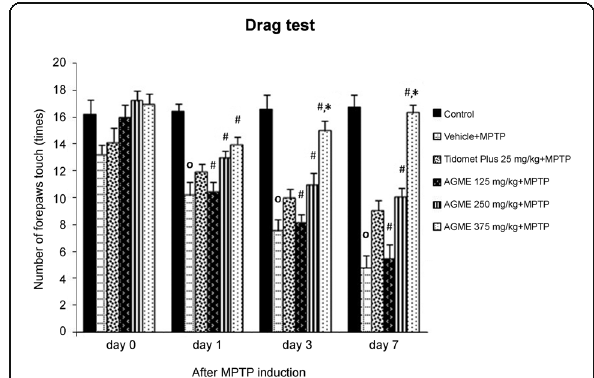
Fig. 1 Effect of AGME extract on number of forepaw touches during the drag test at 0, 1, 3, and 7 days after MPTP treatment. Each data column displays the mean ± SD ( n = 8/group, o - p < 0.001 compared with the control group; #- p < 0.05 compared with the vehicle- treated group; *- p < 0.05 compared with the Tidomet Plus-treated group)